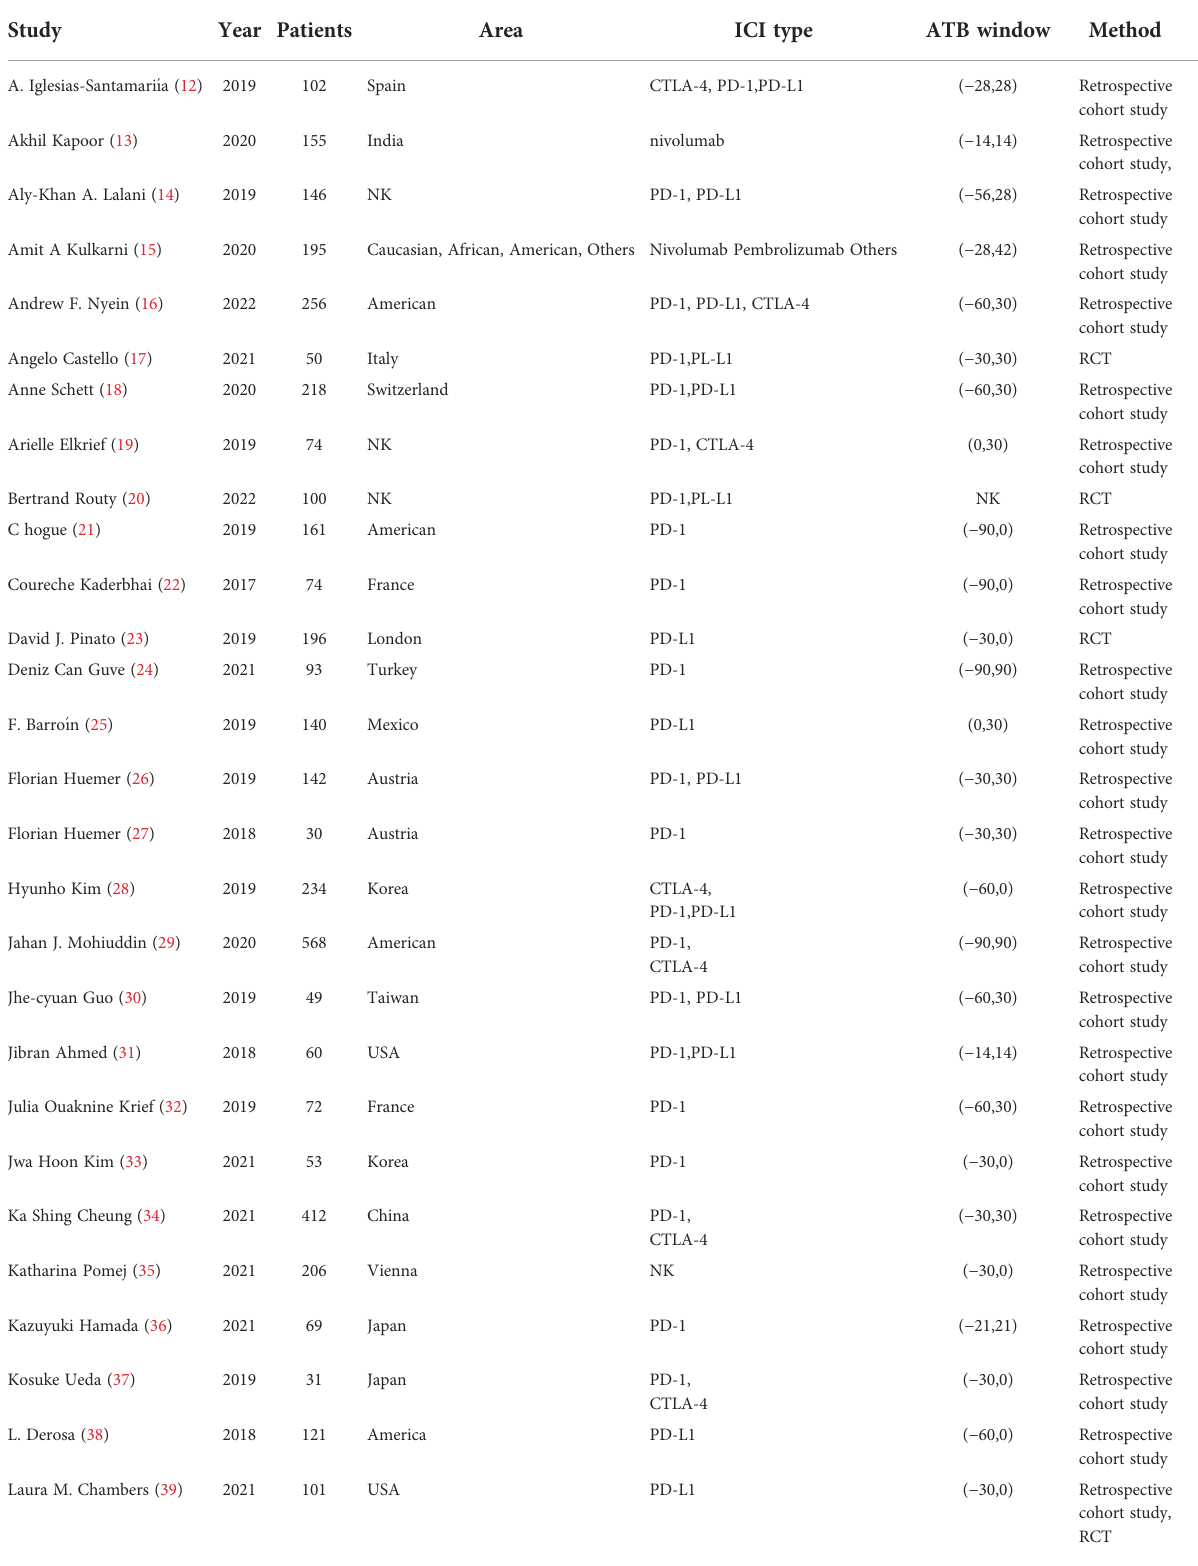
TABLE 1 Basic characteristics of the studies included in the meta-analysis (n = 45).